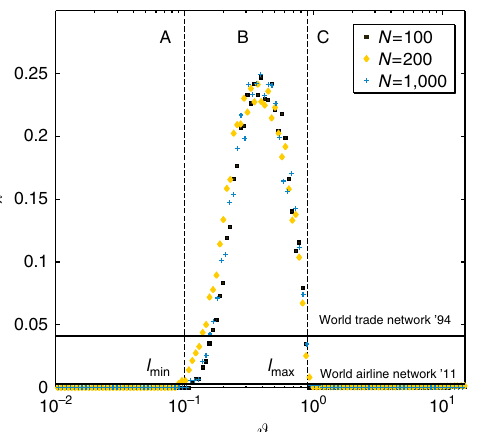
Figure 4 | Core–periphery measure k as a function of ! for different system sizes N . Modelled networks in regime B have a high value of l owing to their core–periphery characteristic and resilience. The World Trade Network from year 1994 lies close to l ¼ 0.041 and the World Airline Network from the year 2011 is at l ¼ 0.0032. The trade network is only comprised of 80 nodes, whereas, the airline network has close to 3,500 nodes. Data are averages over 100 realizations.